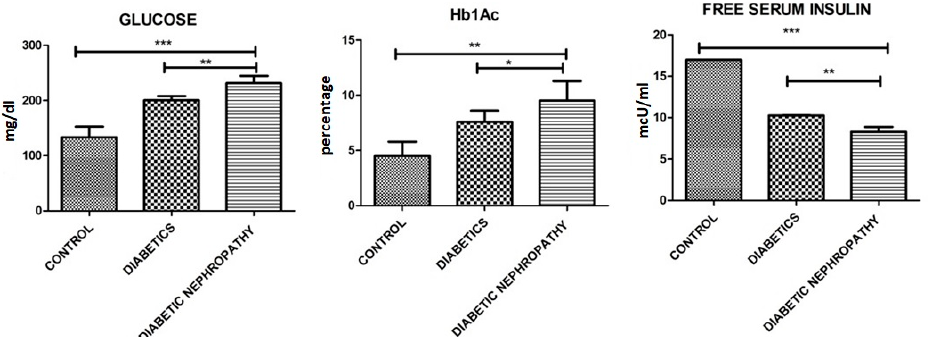
Figure 4. Glucose, Hb1Ac, and free serum insulin. Of all the individuals there is a significant difference between control and diseased group and elevated levels of all the parameters can be observed in DN compared to control and to type 2 diabetes groups. Where p ≤ 0.05. *, **, *** (less, moderate, highly significant) represents the significant difference between groups.